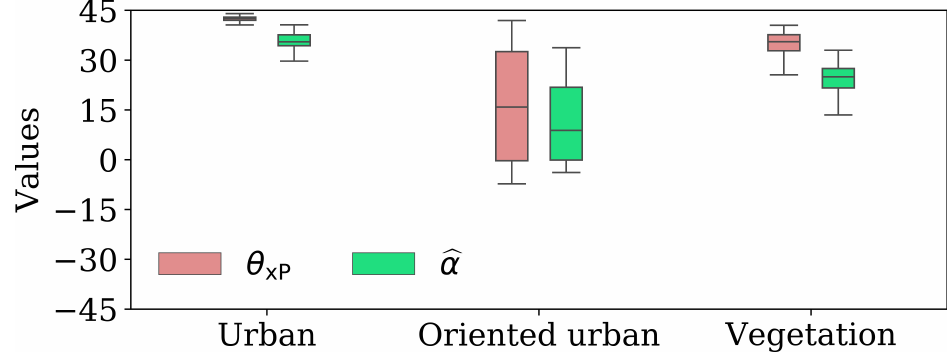
Figure 3. Variations of θ xP and (cid:98) α for different scattering target from RADARSAT-2 data over